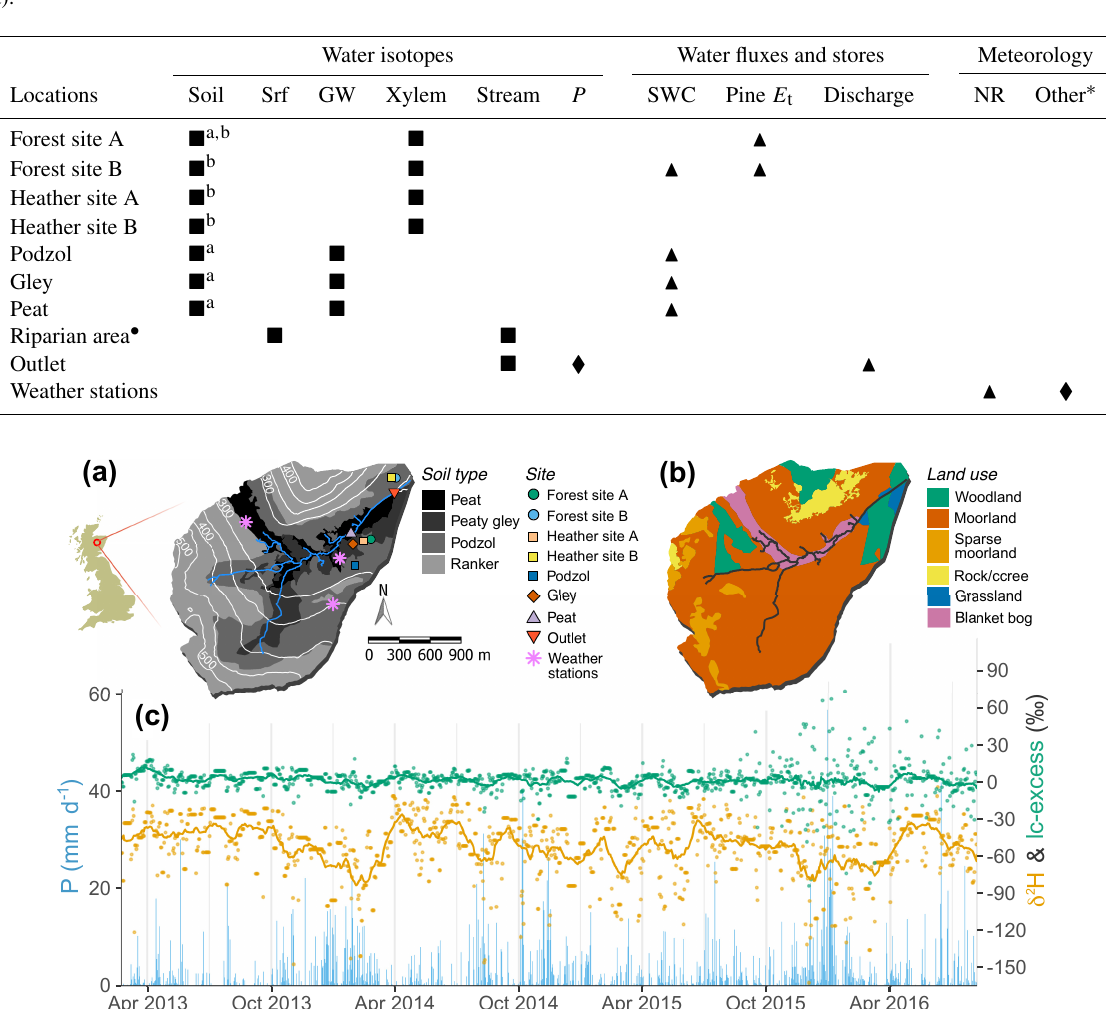
Table 1. Local datasets used in this study, grouped by location and purpose: model evaluation ( (cid:4) ), model calibration ( (cid:78) ), and model inputs ( (cid:7) ). For soil isotopes, a and b , respectively, indicate suction-lysimetric sampling (2013) and direct equilibration from soil sam- pling (2015–2016). Other notations: Srf – surface water, GW – groundwater, P – precipitation, SWC – soil water content, E t – transpiration,